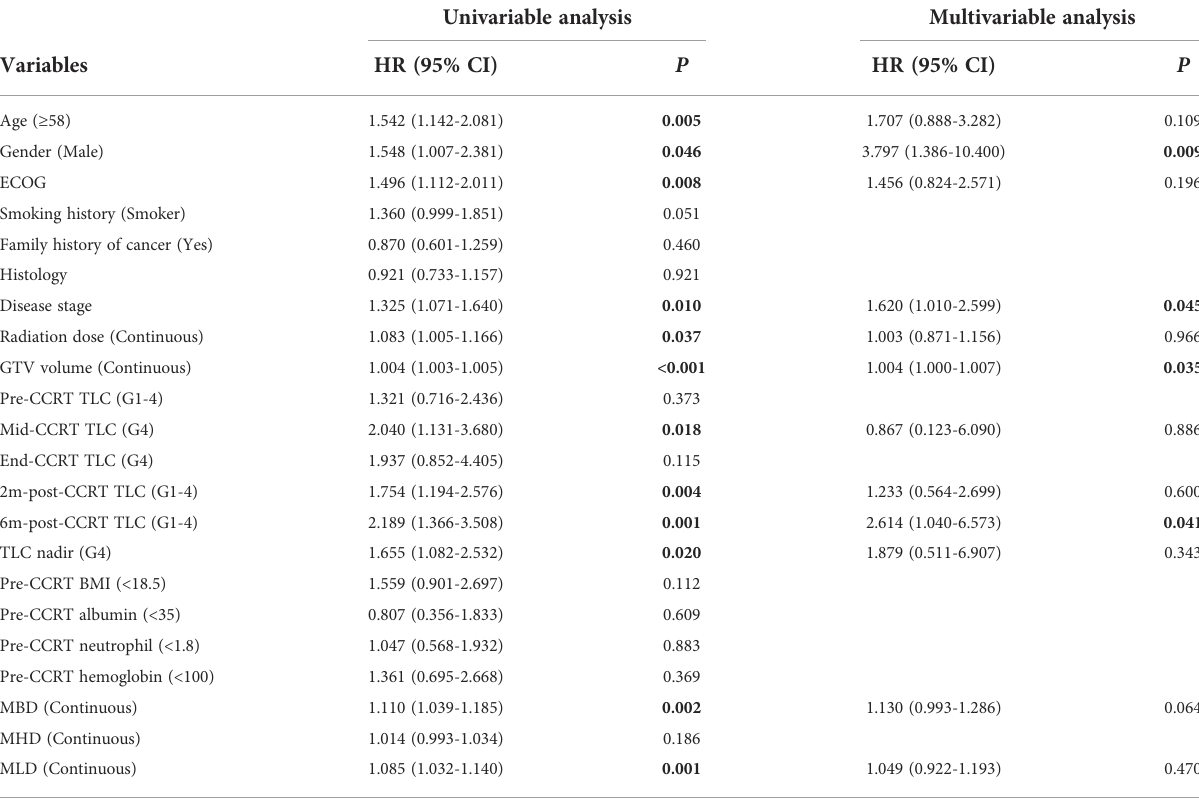
TABLE 3 Univariable and multivariable Cox regression analysis of potential variables associated with OS in LANSCLC patients.